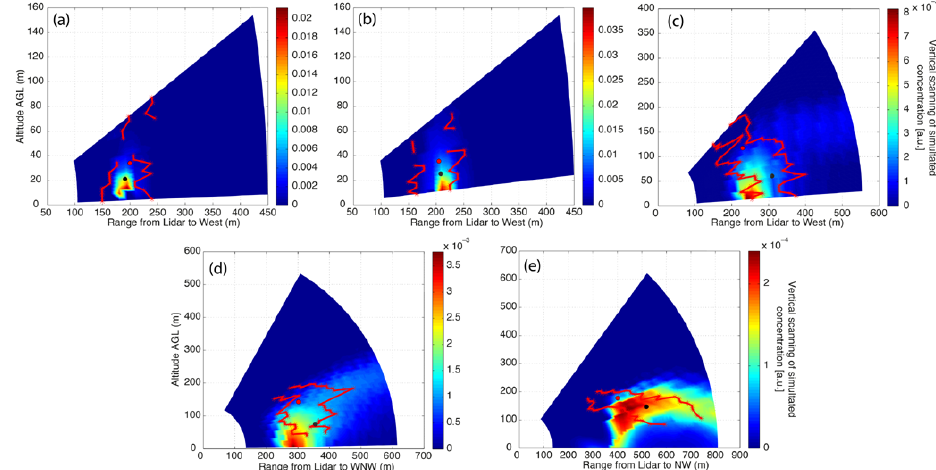
Fig. 8. As Fig. 5 but for the simulated passive tracer concentration. Observed smoke plume edge (red star), experimental (red circle) and simulated (black circle) barycentres are superimposed on the simulated passive tracer concentration vertical cross-sections.